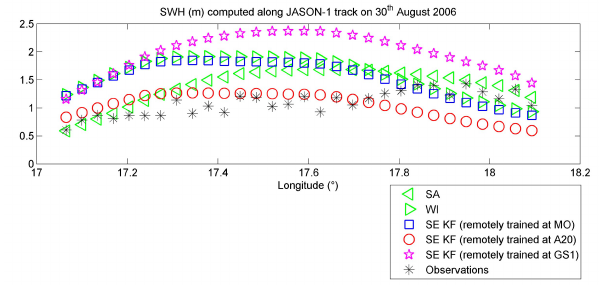
Fig. 8. Individual models and SE forecasts along a JASON-1 track during a strong-wind